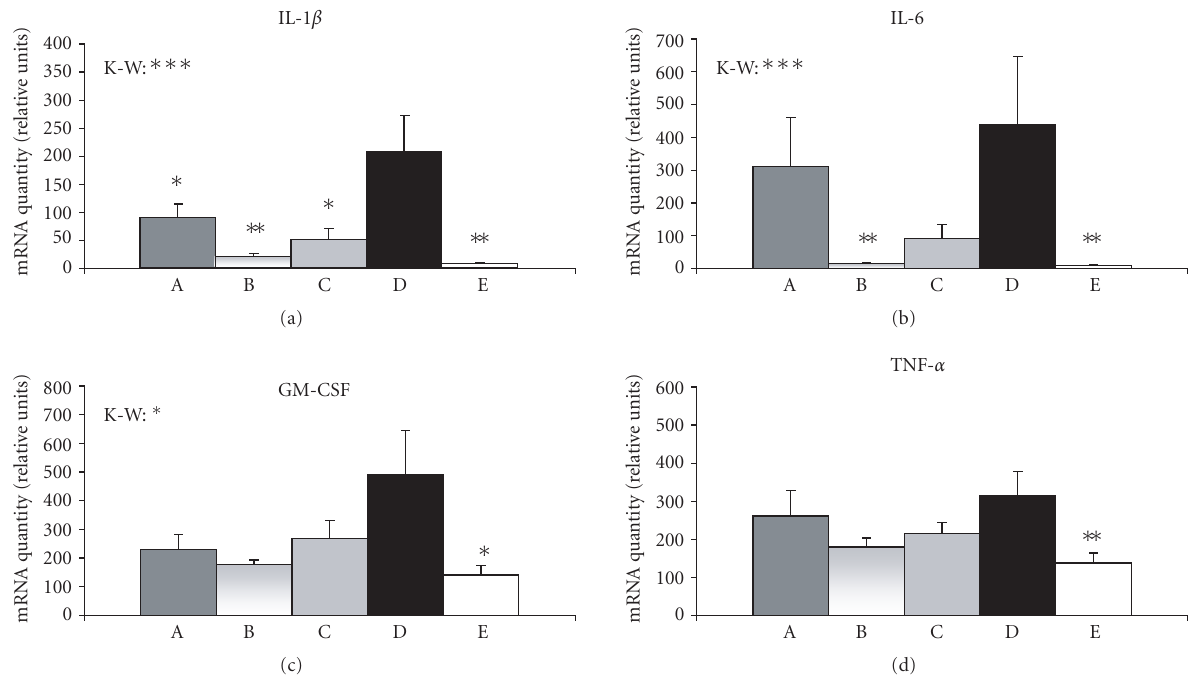
Figure 5: Cytokine mRNA expression. Relative amounts of a cytokine mRNA in each sample were divided by the normalization factor (geometric means of HPRT, SDHA and, β -actin amount) of the sample. Values are arithmetical means + SEM, n = 6 − 8. Statistical significance was assessed using the Kruskal-Wallis test (K-W, di ff erences between all groups of animals) and Mann-Whitney test (di ff erence between group D and other groups of animals); ∗ P ≤ . 05, ∗∗ P ≤ . 01, ∗∗∗ P ≤ . 001. A, colitic animals fed with the combination of 0.4% thyme and 0.2% oregano oils; B, colitic animals fed with the combination of 0.2% thyme and 0.1% oregano oils; C, colitic animals fed with the combination of 0.1% thyme and 0.05% oregano oils; D, animals with TNBS-induced colitis; E, control sham animals.